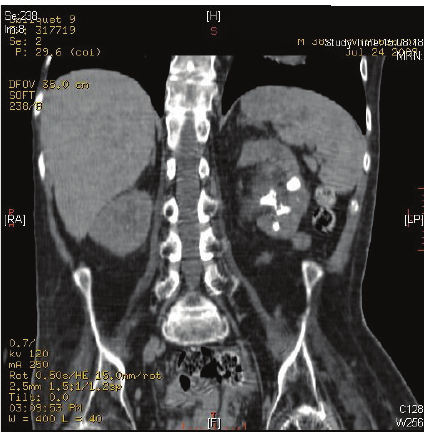
Figure 4: CT of chest, performed on 05 August 2009, revealed atelectasis and consolidation posteriorly in the right upper lobe and in both lower lobes. There was a moderately large right-sided pleural effusion.